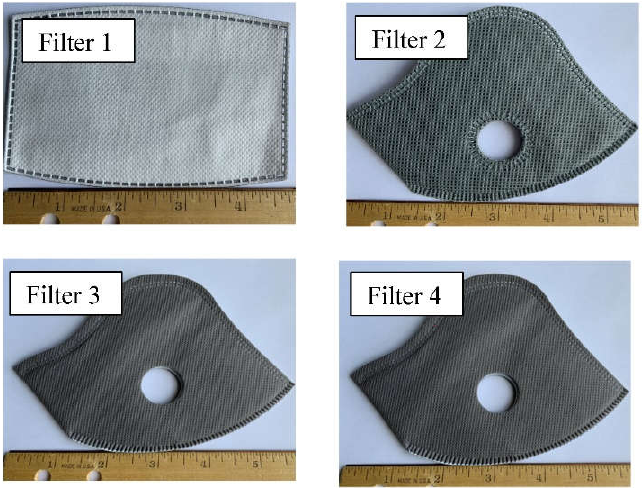
Figure 1. Four types of face mask inserts with an activated carbon layer were used in this study. Each picture represents a different manufacturer’s filter insert.